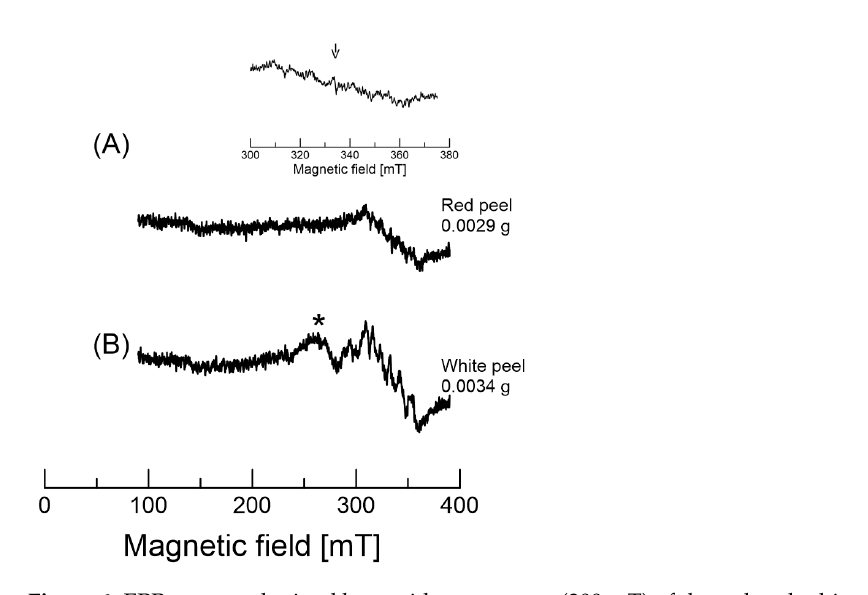
Figure 5. The inhibition effect on COX-2 production in LPS/IFN- γ -induced RAW 264.7 cells of selected anthocyanin extracts (RP, WP, RPe, and WPe). * Significant differences at the 95% confidence interval compared to control RAW 264.7 cells treated with LPS and IFN-γ.